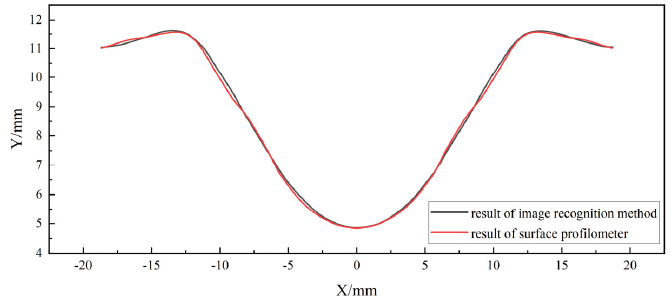
Figure 9. Surface coordinates measured with the two methods.